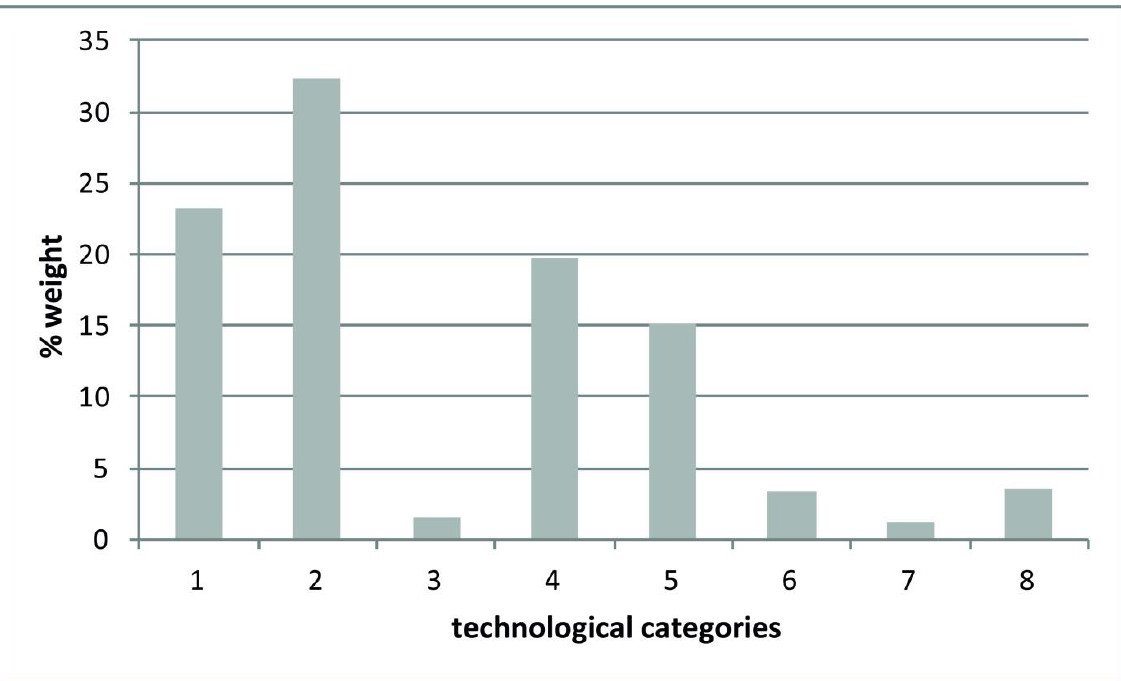
Figure 8. Techno-economical diagram of the laminar production in fine-grained flint from Hesbaye (in weight, g). 1. big flakes of the beginning of the shaping out, 2. flakes coming from the preparation of the crests, 3. crests, 4. maintenance flakes of the debitage, 5. blades, 6. flakes attributed to the blades production but which can’t be precisely replaced in the chaîne opératoire, 7. very little flakes that those produced by retouches and the tools spall, 8. final waste of the production which are the cores and the flakes from the recovery of the cores. Based on 275 pieces (1674